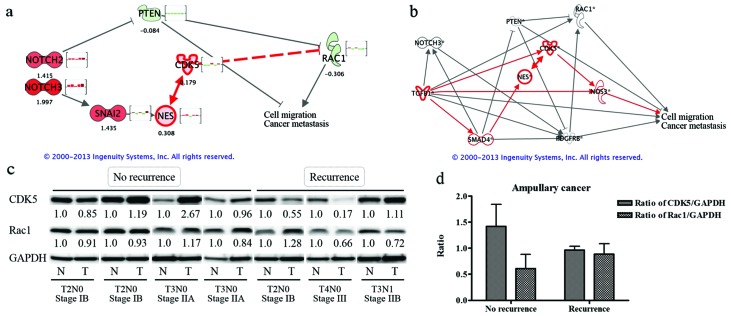
Upstream mediators and downstream signaling of nestin. (a and b) Gene network is generated through the use of Ingenuity Pathway Analysis (IPA). Gene network is represented as nodes and lines between two nodes. Node shapes symbolize the functional class of the gene product: inverted bell, cytokine and growth factor; hook, enzyme; trefoil, kinase; dumbbells, transcription regulator; tilted pot, phosphatase; circle, complex or other. The bar graphs to the right of the particular molecules depict the relative fold-change of the particular gene and the bar from left to right is represented as different patients. Red bar indicates that the gene is higher in cancer than normal and a green bar indicates that it is lower in cancer than normal. Bold nodes with red rims represent genes associated with nestin. (a) The expression pattern of nestin is opposite to the pattern of RAC1. (b) Activation of multiple oncogenic pathways and knockdown of tumor suppressors form a complex network to induce cell migration and cancer metastasis. (c) Detection of cyclin-dependent kinase 5 (CDK5) and Rac1 by western blotting. GAPDH served as a quantitative control. The fold-change of CDK5/GAPDH or Rac1/GAPDH is labeled below the band. N, normal tissue; T, tumor tissue. (d) Ratio of CDK5/GAPDH or Rac1/GAPDH expression was compared between patients with or without recurrence. An increased ratio of CDK5/GAPDH and a decreased ratio of Rac1/GAPDH were detected in patients without recurrence but not in patients with recurrence.